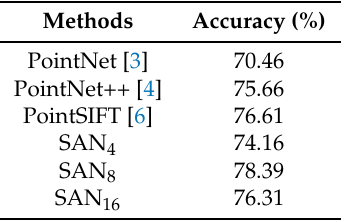
Table 2. The overall accuracy comparison of different methods on S3DIS.